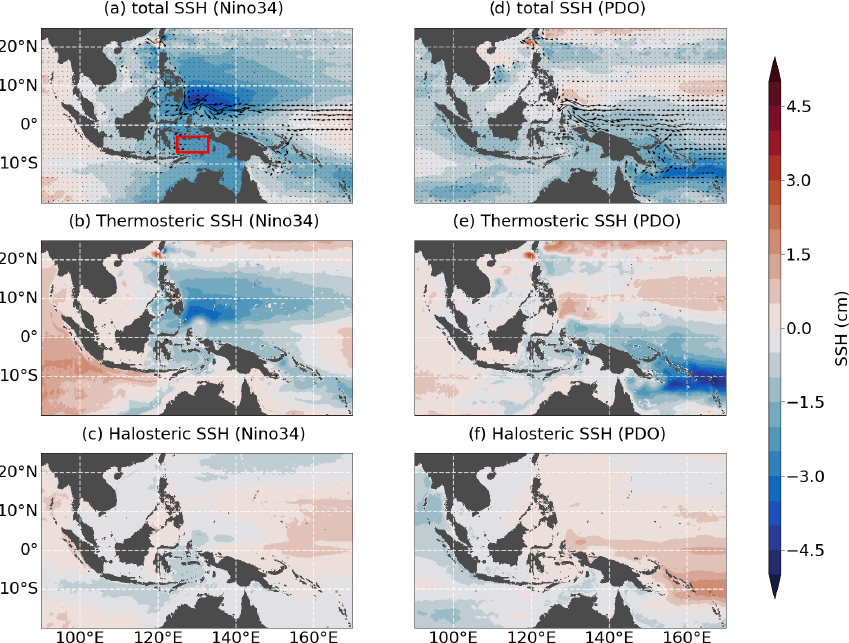
Figure 7. Linear regression with the (a–c) Niño3.4 and (d–f) PDO index of upper-ocean currents (arrows; 0–150m) for total, thermosteric, and halosteric SSH. All data are taken from REF005 and were filtered with an 8-year low-pass filter. Note that the colour shading in panels (a) and (b) is the same as in Fig. 5a and